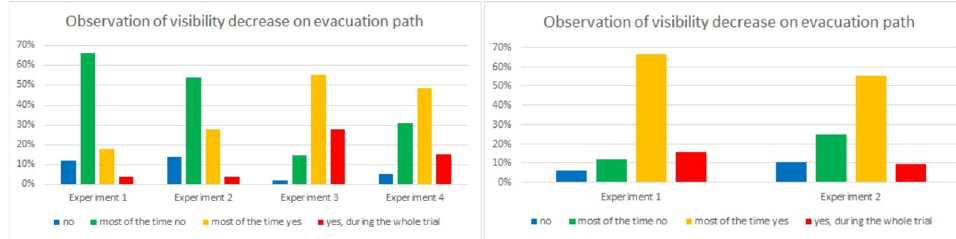
Fig 13. Pedestrians’ observations on visibility loss—question 4. (Results from the Laliki experiment are on the left; results from Gda ń sk on right).